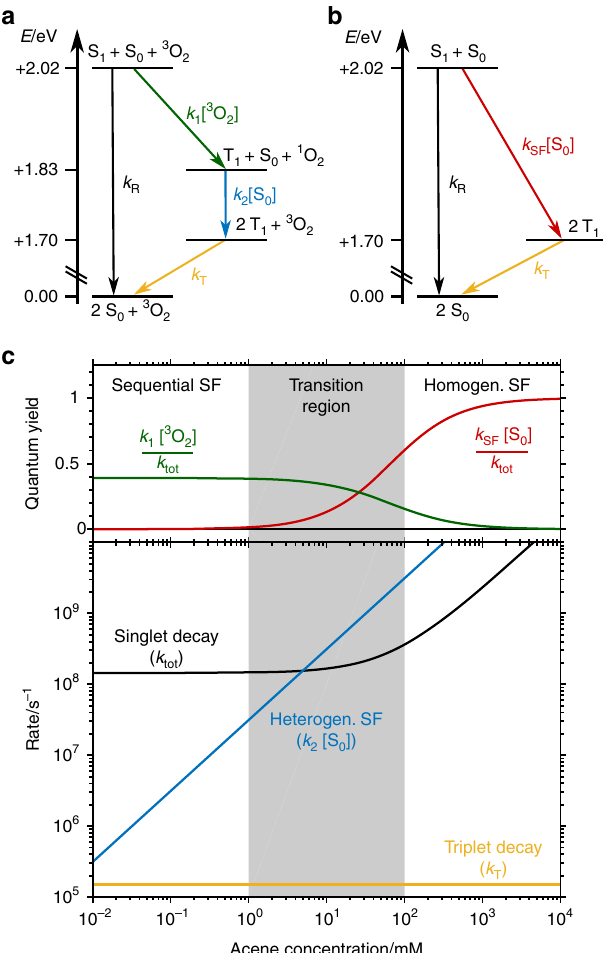
Fig. 2 Reaction mechanisms and expected concentration dependence. a Scheme for the mechanism of oxygen-catalysed singlet fi ssion of TIPS-Pn in solution with rate constants. An identical mechanism is proposed for TDCl 4 . Owing to the relative energies of S 1 and T 1 compared to 1 O 2 , the individual steps of sequential singlet fi ssion are exothermic. b Scheme for the mechanism of homogeneous singlet fi ssion in TIPS-Pn with corresponding rate constants. c Upper panel: expected chromophore concentration dependence for the quantum yields of homogeneous (red) and sequential (green) SF. Lower panel: expected chromophore concentration dependence for rate constants of the individual processes. The association of an excited and ground-state chromophores ( k SF ) is the rate-limiting step of homogeneous SF. SF is outweighed by concentration independent, non-SF relaxation pathways (i.e., fl uorescence, internal conversion and, to a minor extent, intersystem crossing) for low chromophore concentrations and in the absence of oxygen ½ (cid:6) (cid:7) k (cid:7) k S (black, k ). At higher chromophore concentrations, k 0 tot R tot SF (black). In contrast, the rate of the fi rst step in sequential SF, that is, the energy (cid:1) (cid:3) transfer ( k 1 3 O 2 ), is not affected by the chromophore concentration because 3 O 2 is in excess compared to the excited chromophore. However, the subsequent heterogeneous singlet fi ssion (blue, k 2 S 0 ½ (cid:6) ) exhibits a pseudo- fi